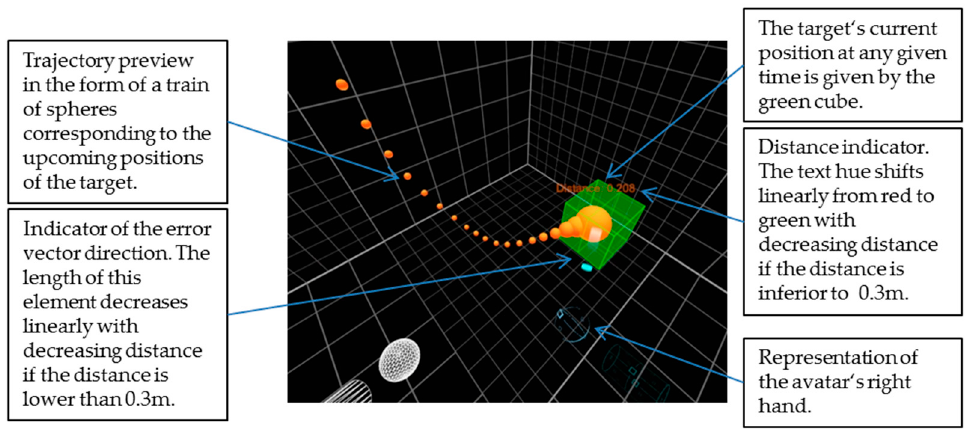
Figure 2. A representative screenshot of the Virtual Reality (VR) simulation with description of each element.